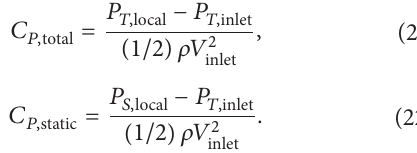
Figure 16: Refined measurement grid, 868 points.